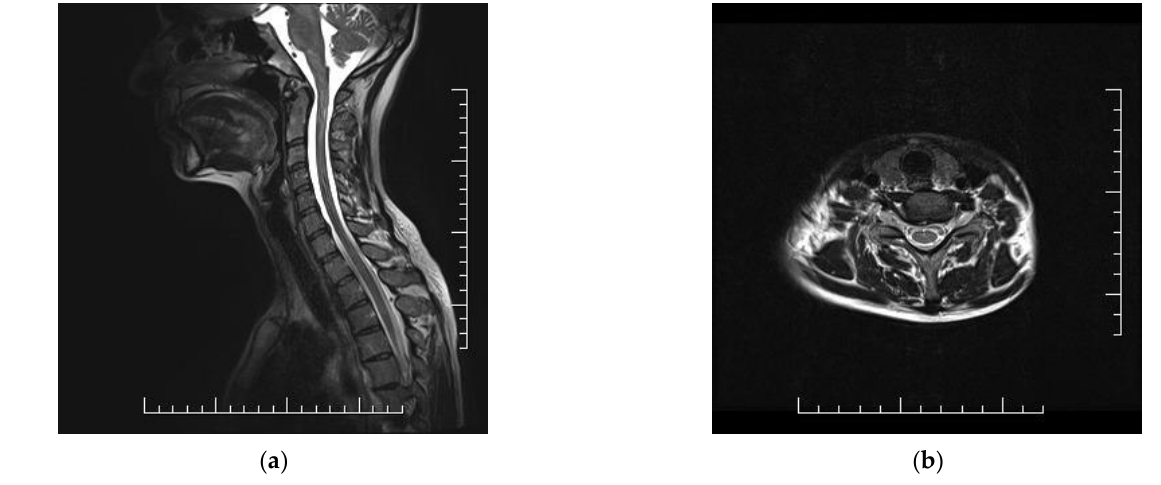
Figure 1. Minor morphological changes in MRI scan of cervical spine in 38-year-old woman with migrating pseudoradicular symptoms in COVID-19 without previous history of cervical vertebral algic syndrome. ( a ) Sagittal T2-weighted sequence; ( b ) Axial T2-weighted sequence.